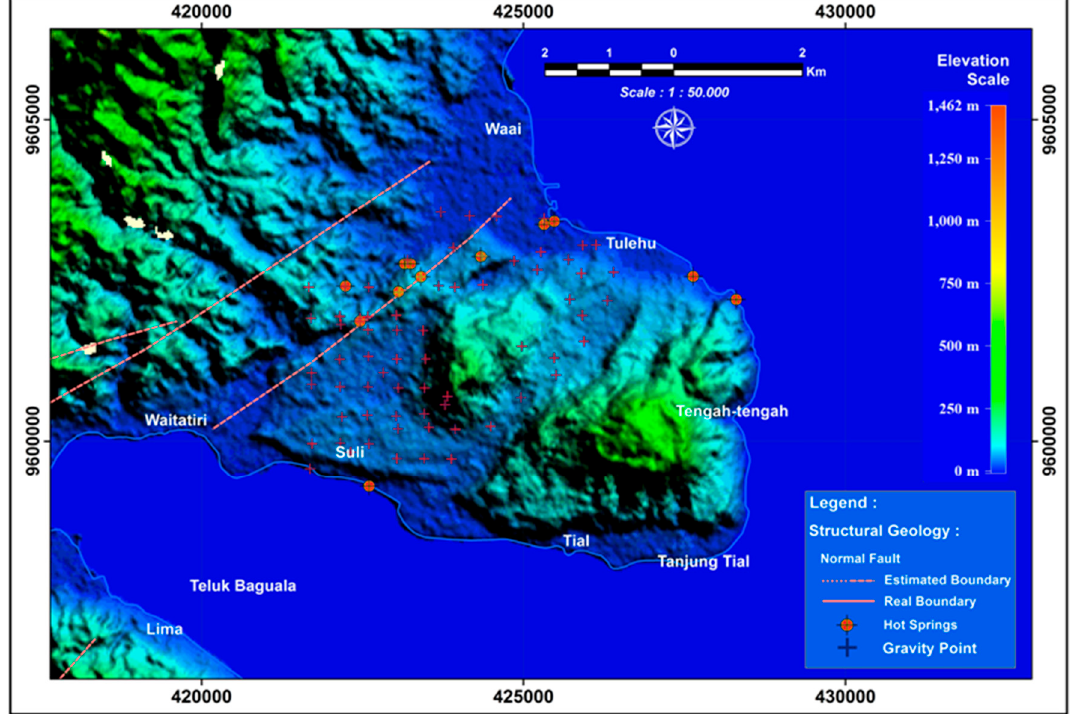
Figure 2. The research location of Suli and Tulehu geothermal areas in Ambon Island, Maluku